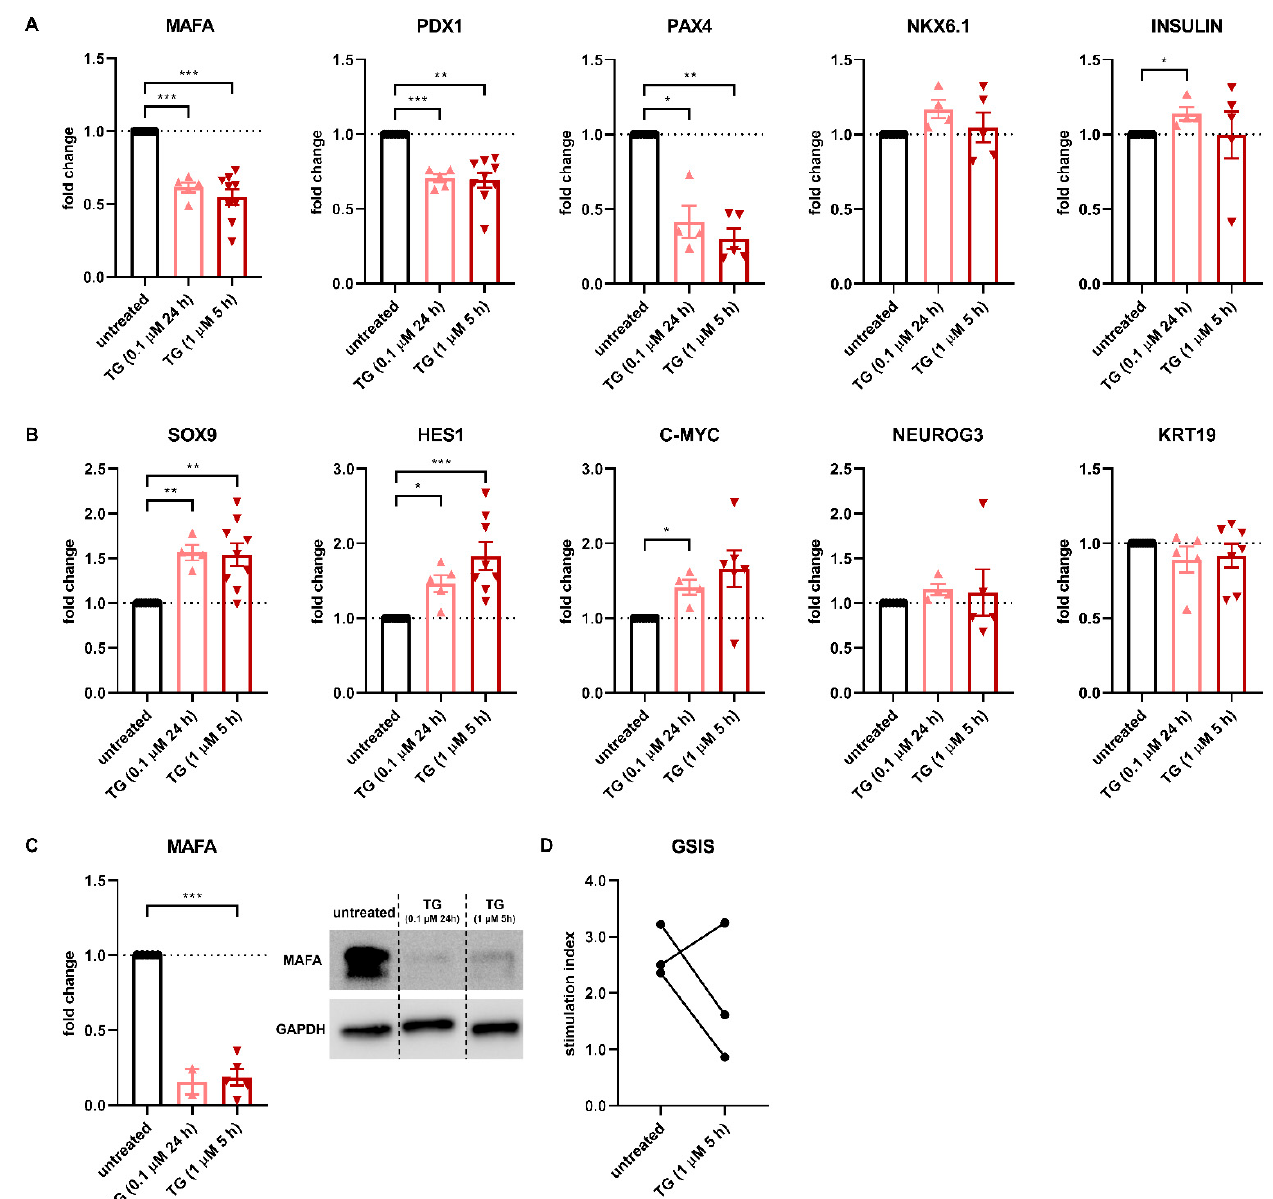
Figure 3. ER stress leads to β -cell dysfunction through loss of β -cell identity. ( A ) To evaluate the effect of ER stress on β -cell identity, islets were treated with the ER stress-inducing compound thapsigargin (TG). Treatment of isolated human islets with 0.1 µ M TG for 24 h and 1 µ M TG for 5 h leads to decreased gene expression levels of the β -cell-specific genes MAFA, PDX1 and PAX4 as measured by qPCR. ( B ) ER stress induction in human islets by treatment with 0.1 µ M TG for 24 h and 1 µ M TG for 5 h leads to increased gene expression levels of the endocrine progenitor genes SOX9, HES1 and C-MYC as measured by qPCR. mRNA expression levels of NEUROG3 and KRT19 were unchanged upon TG treatment. ( C ) Levels of β -cell-specific protein MAFA are decreased in islets upon treatment with 0.1 µ M TG for 24 h and 1 µ M TG for 5 h, as assessed by Western blot. ( D ) TG-induced ER stress in human islets leads to decreased glucose-stimulated insulin secretion in two of three donors. Data are presented as means ± SEM of fold change over untreated control islets. n = 4–9 donors; each data point represents one donor. * p < 0.05, ** p < 0.01, *** p < 0.0005 vs. untreated control